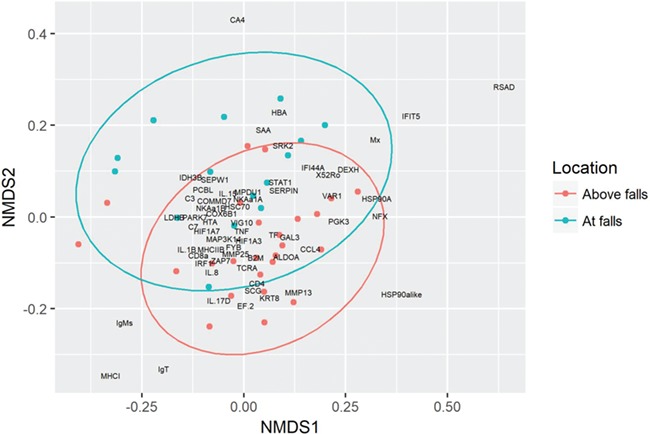
An NMDS plot of host gene expression in the gill tissues of Bulkley River steelhead (n = 40). The colour represents fishery/sampling location (red represents angling upstream of falls; blue, dip net at falls). Confidence ellipses (95%) are shown in blue and red. The most influential variables on NMDS1 are RSAD (8.7%), IFIT5 (5.6%) and HSP90alike (5.3%) and on NMDS2 are CA4 (6.9%), MHCI (5.9%) and IgT (5.7%).